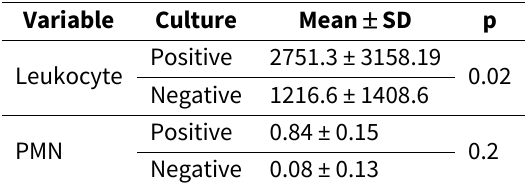
Table 3. Comparison of Leukocytes and PMN Based on Culture Results